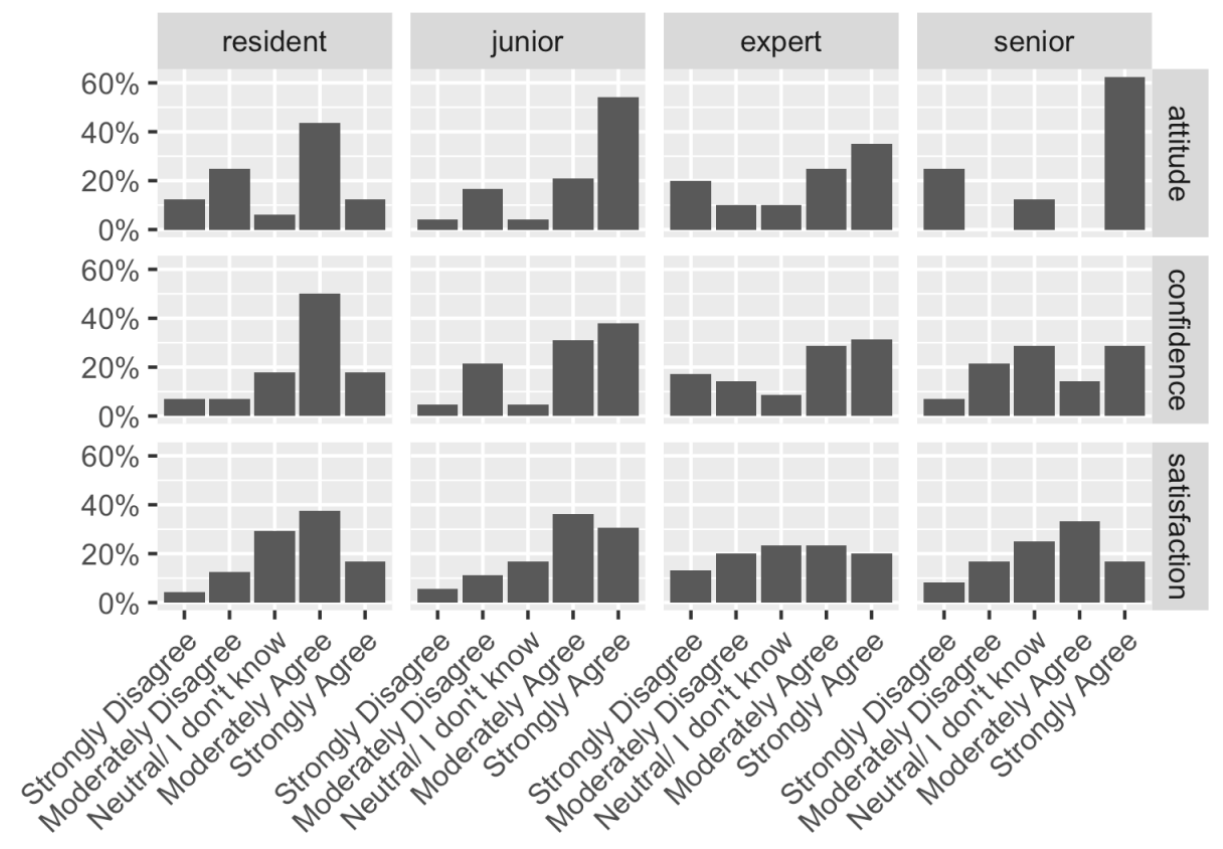
Figure 4. Overview of the psychological aspect of the study. This series of graphs summarize the results of the survey conducted among pathologists at different career levels (residents, junior, expert, and senior) to evaluate their attitudes toward, confidence in, and satisfaction with digital pathology